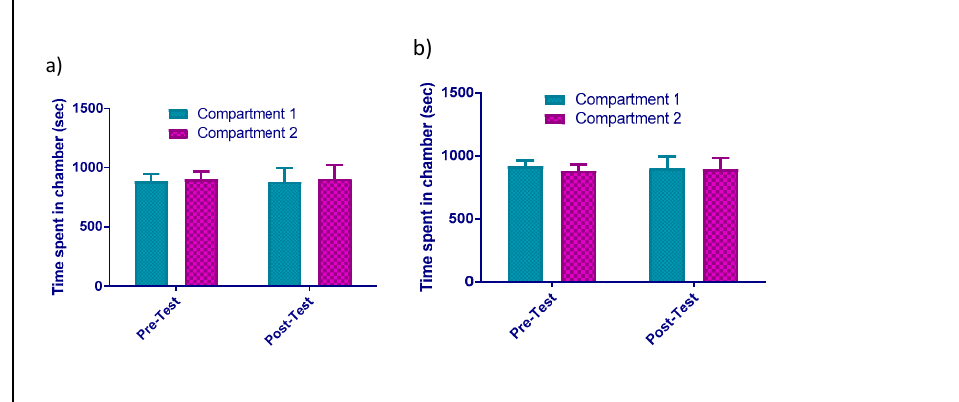
Figure 2. ( a ) Effect of vehicle on CPP. Time spent (mean ± SEM) of vehicle-treated groups was examined. There was no significant difference in time spent in pre- and post-test in control group. ( b ) Effect of NAC on CPP. Time spent (mean ± SEM) did not significantly change in the vehicle- and NAC-treated groups in the pre- and post-test.